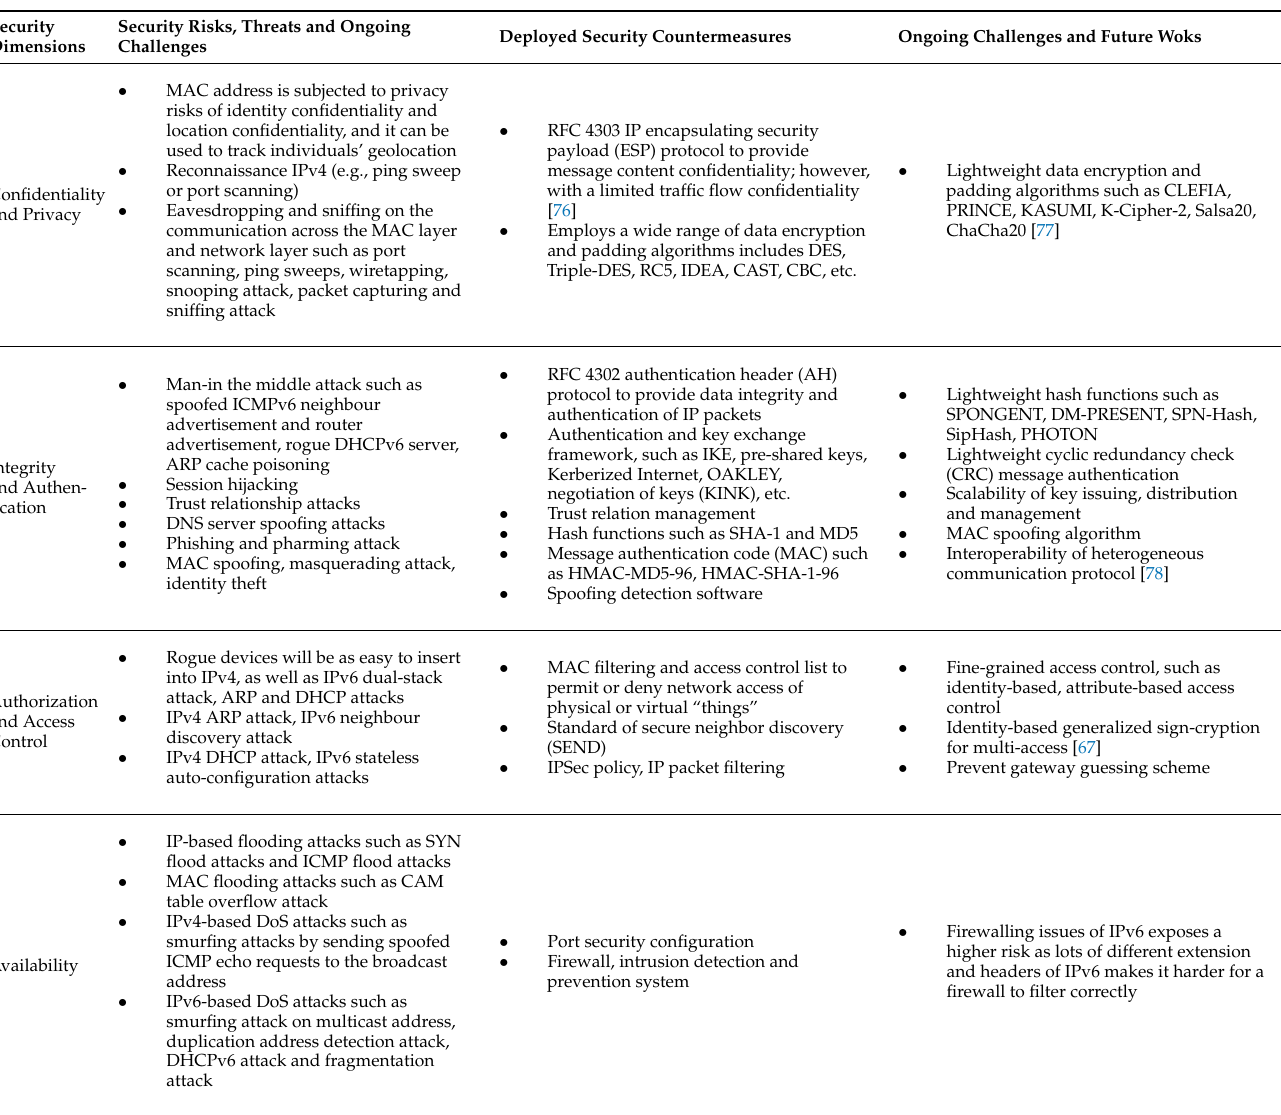
Table 6. Security analysis on media access control (MAC) and Internet protocol (IP)